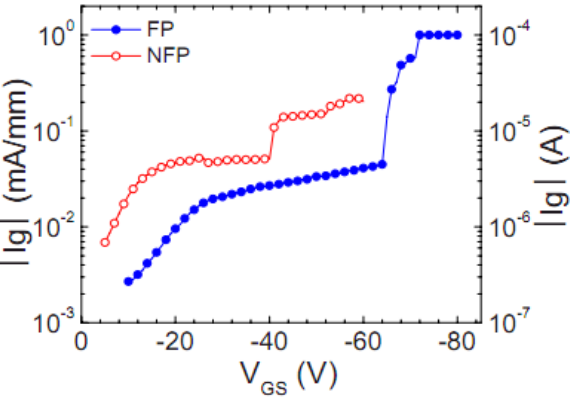
Figure 7. Off-state gate currents as a function of V and without source fi eld plate